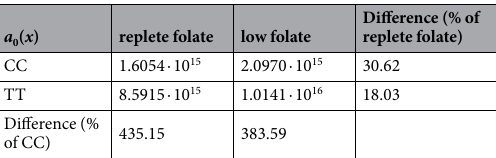
Table 11. Total propensities obtained in four steady state conditions according to folate polymorphism (CC and TT case) and total concentration of available folate (replete, 18 µ M; low, 9 µ M). To help comparisons, the differences between CC and TT (in % of CC) and between replete and low total folate (in % of replete folate) are indicated. A steady state that is less stable (or more noisy) than another one has higher total